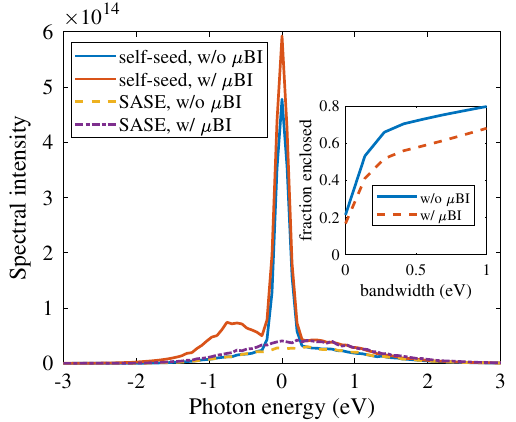
FIG. 2. The hypothetical, one typical single-shot and the average (500 shots) bunching factor spectra of the μ BI. The peak amplitude of the hypothetical spectrum b μ The inserted figure shows the current profile that corresponds to the single-shot bunching spectrum.